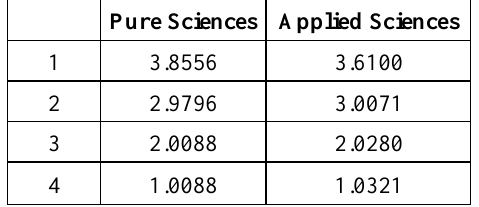
Table 9. Expected duration of study before graduating (years).